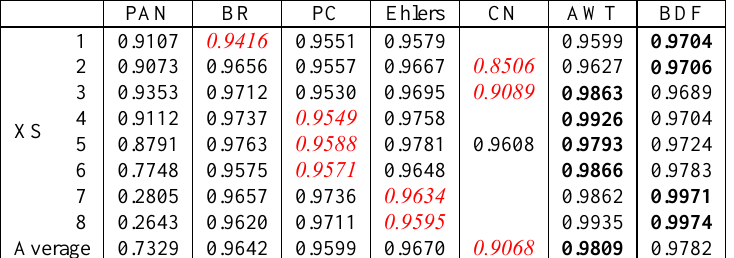
Table 7. CC between Worldview-2 multispectral and fused images using different algorithms